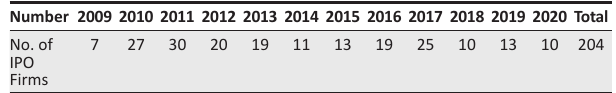
TABLE 1: IPO firm distribution during